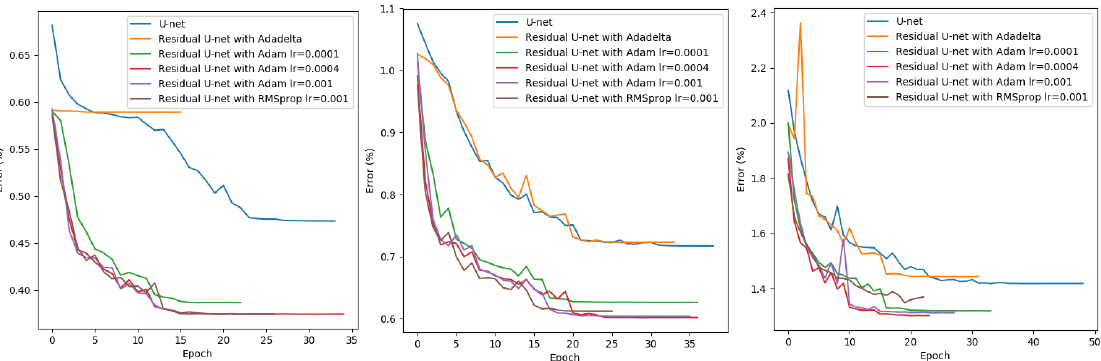
Figure 8. Learning curves of network architectures using different optimizer at target scale 1:10,000 ( left ), 1:15,000 ( middle ) and 1:25,000 ( right ) based on validation set.